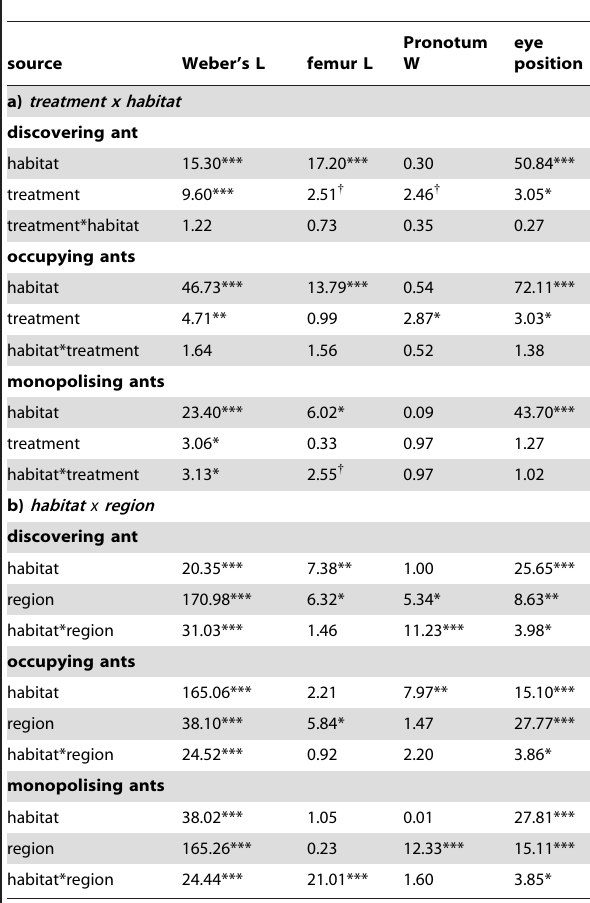
Table 2. F-values from ANOVA testing the effect of region, foraging strategy and their interaction (df =2,2,4) on morphological features of